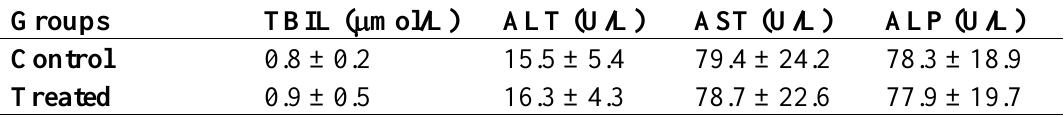
Table 4. Changes of biochemical parameters in the serum of mice induced by C. fistula seed